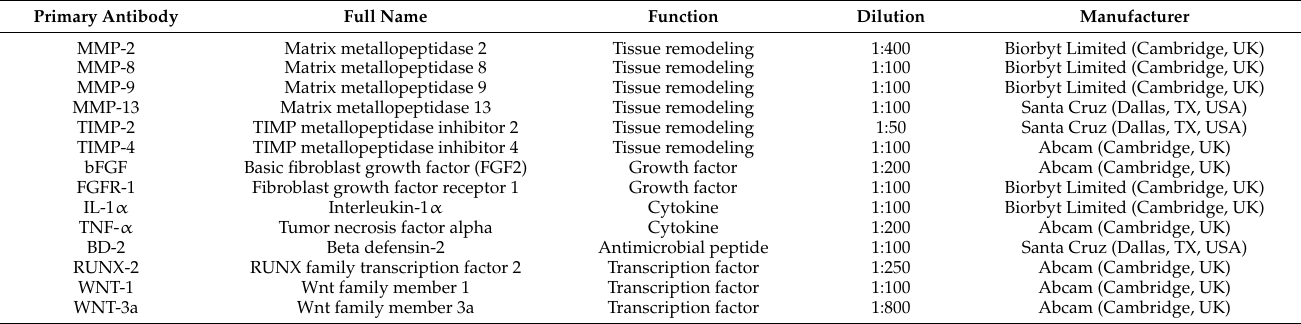
Table 1. Description of the primary antibodies used for evaluation.